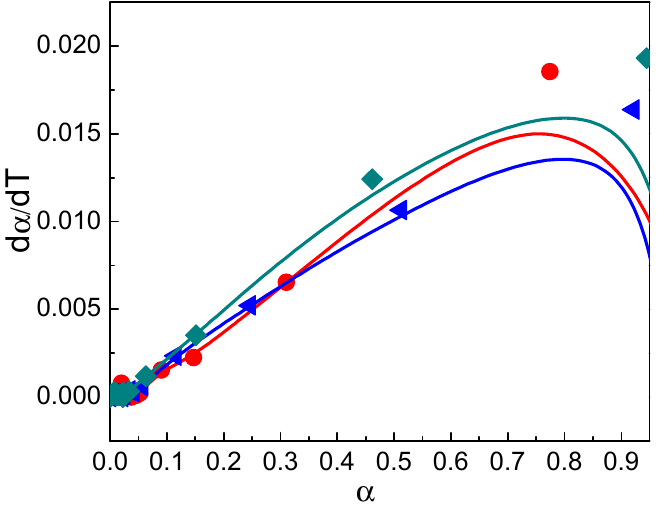
Figure 11. d α as function of α for the sample PS / Mg2ZnAl-AAC (15 wt.%) at (cid:8) β = 10 ◦ C / min, (cid:74) β = 20 Figure 11. (cid:3031)(cid:3080) as function of α for the sample PS/Mg2ZnAl-AAC (15 wt.%) at ● 𝛽 = 10 °C/min, (cid:31) 𝛽 = dT (cid:3031)(cid:3021) ◦ C / min, and (cid:7) β = 30 ◦ C / 20 °C/min, and ♦ 𝛽 = 30 °C/min.